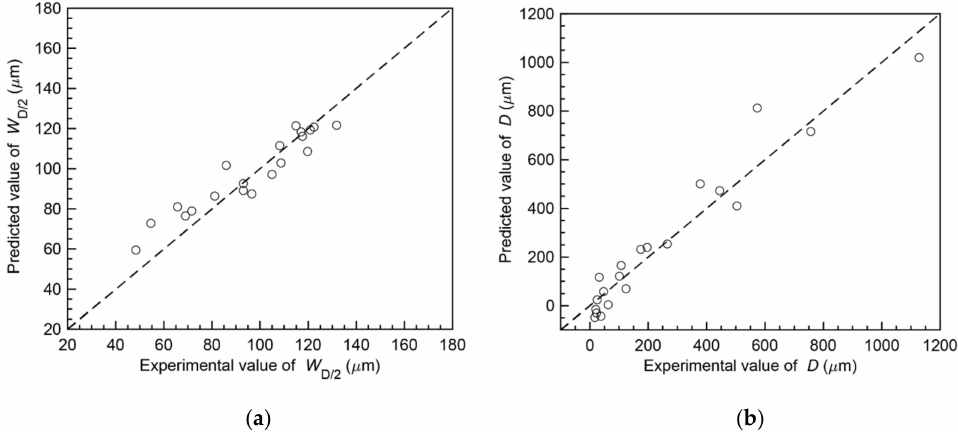
Figure 10. Comparison between experimental melt pool dimensions and results predicted by the neural network: ( a ) melt pool width at half melt pool depth W D /2 ; ( b ) melt pool depth D .